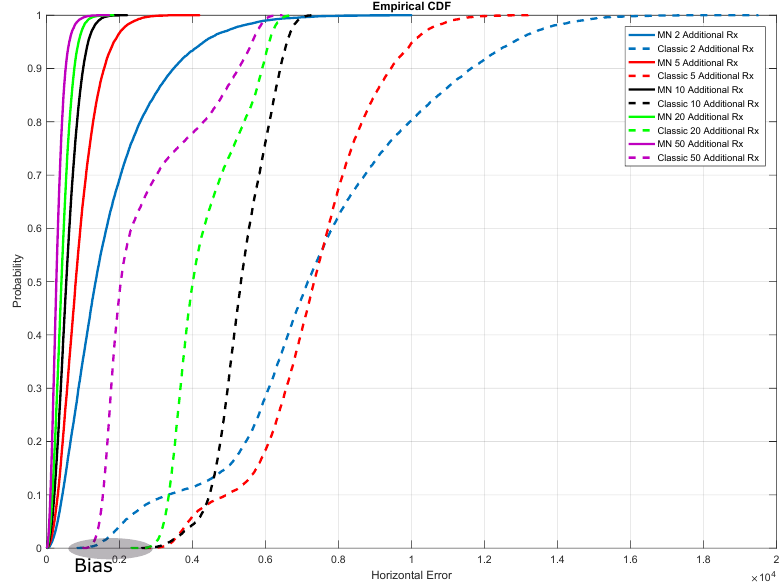
Figure 15. CDFs of the horizontal position errors for the traditional (sketched lines) and the MN TDOA (continuous lines) algorithms. Five configurations of the receiving network are considered: BL+2Rx (blue), BL+5Rx (red), BL+10Rx (black), BL+20Rx (green) and BL+50Rx (purple). The horizontal error on the x-axis is expressed in metres (multiplied for a factor 10,000). Note that, for each configuration, the error was computed at each point of the trajectory in order to account for the different geometric